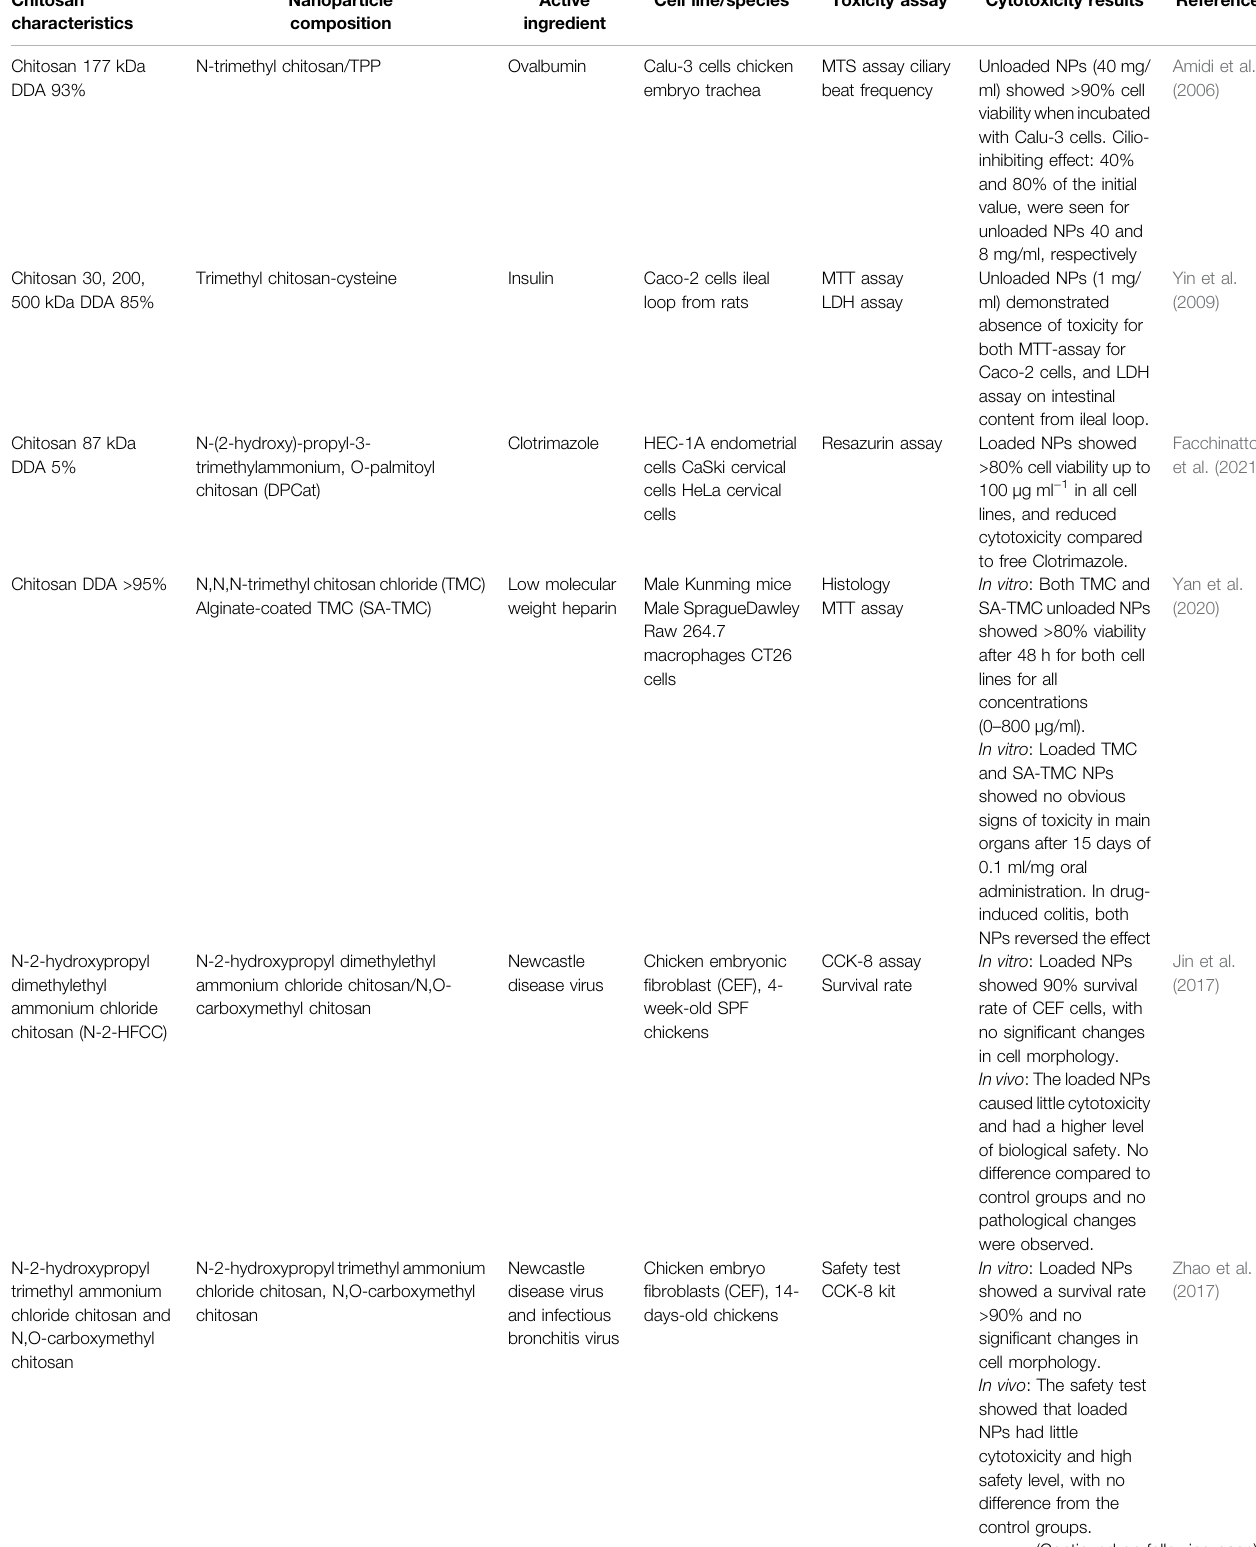
TABLE 6 | Articles on nanoparticles with quaternized chitosan, main fi ndings. Chitosan